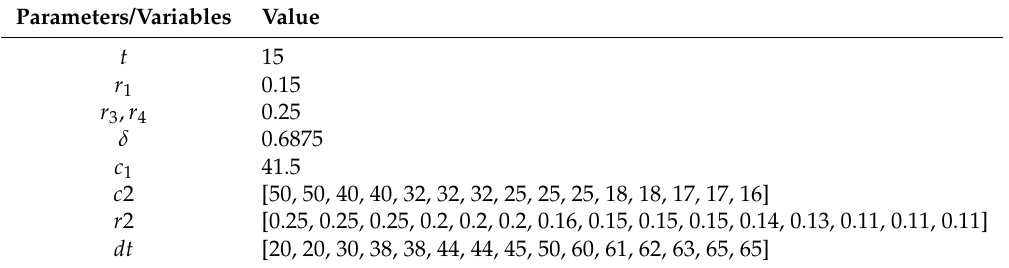
Table 4. Values settings of parameters and exogenous variables